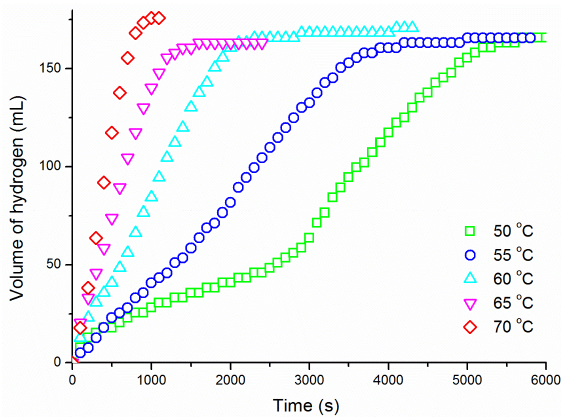
Figure 2. ( a ) Plots of hydrogen volume versus time for the dehydrogenation of dimethylamine borane catalyzed by 5.0 mM Ru(acac) 3 as pre-catalyst with different substrate concentrations at 60.0 ± 0.1 °C. ( b ) The plot of hydrogen generation rate versus the concentration of dimethylamine borane, both in logarithmic scales.